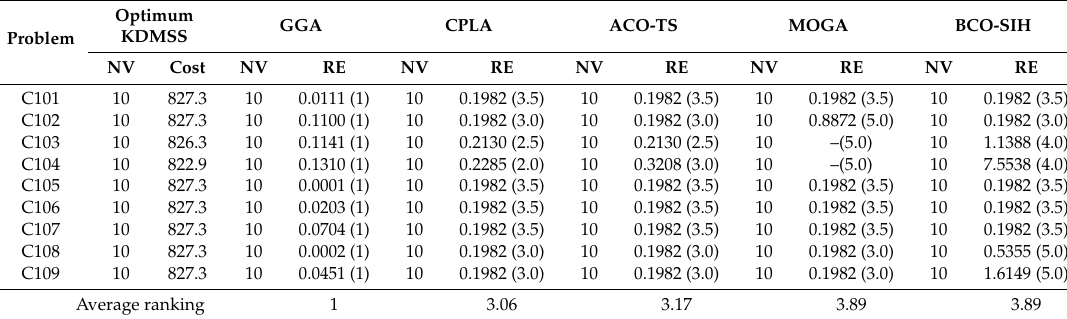
Table 6. Comparison of the experimental results with nine Solomon benchmark problems.